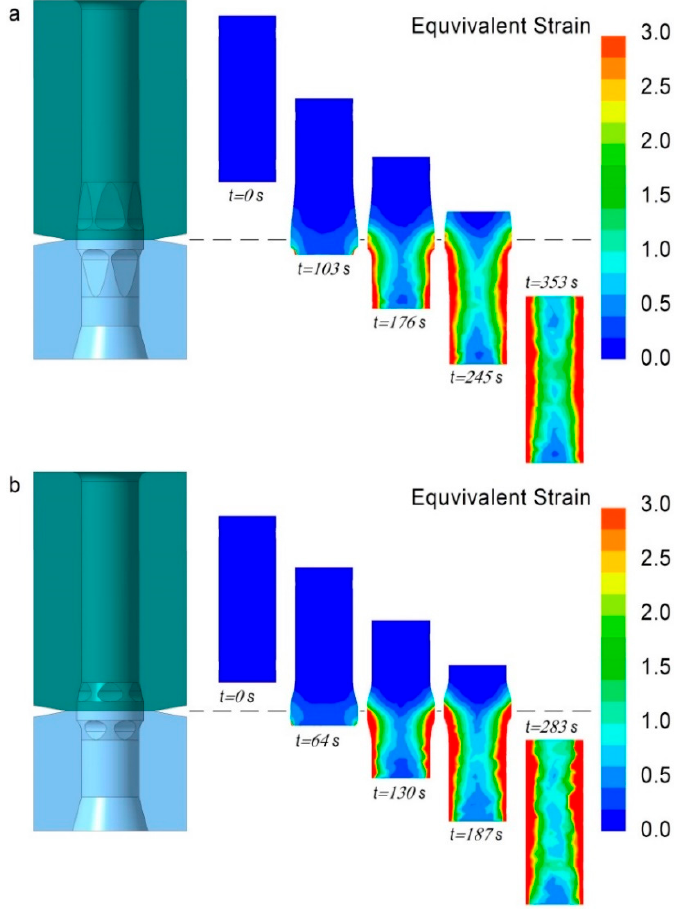
Figure 4. The equivalent strain distributions in the transversal cross-section through the middle of the sample calculated by ( a ) variant 1 and ( b ) variant 2 by means of